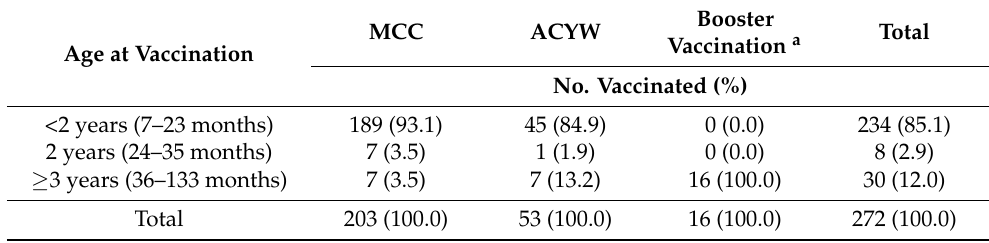
Table 1. Number of enrolled participants distributed by age at vaccination and type of vaccine. MCC Age at Vaccination